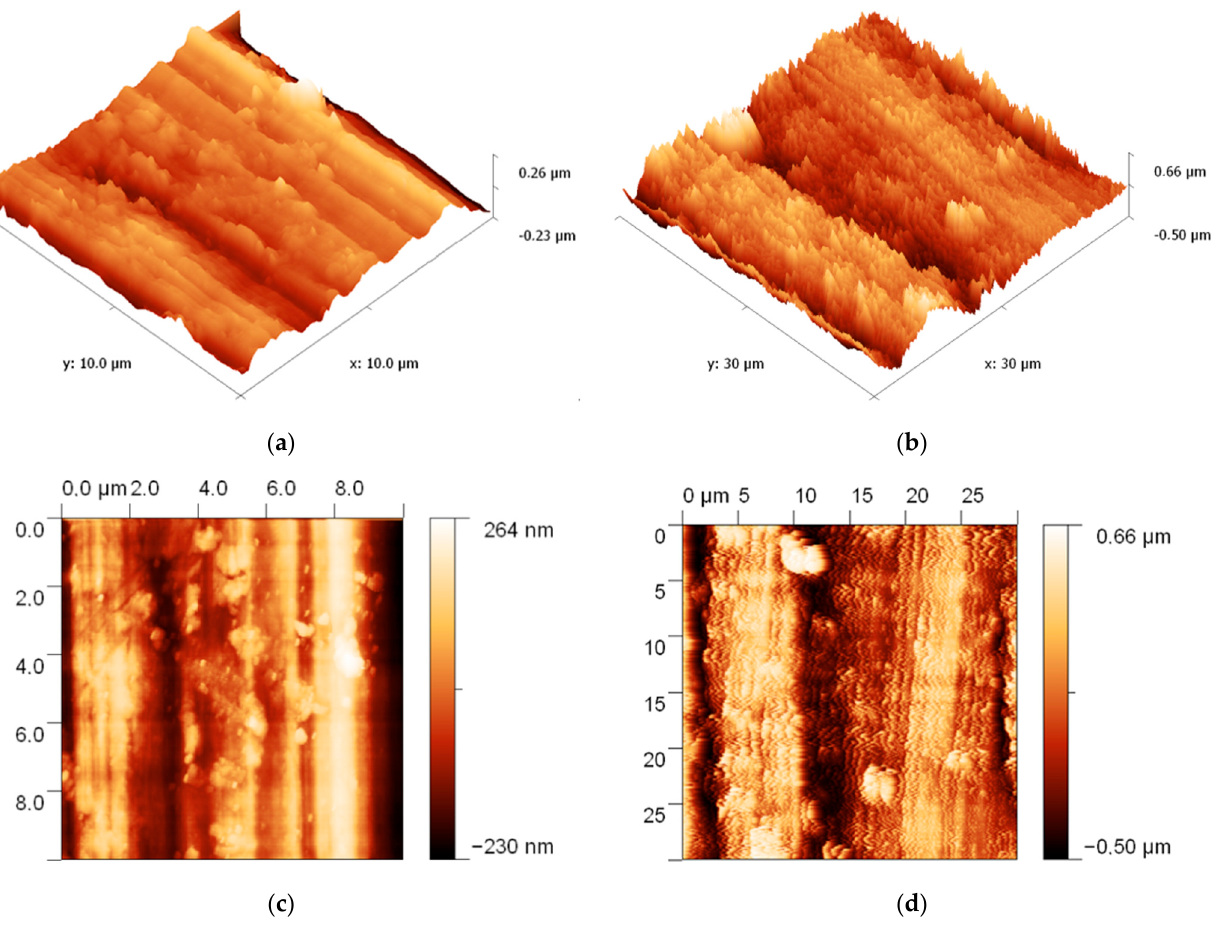
Figure 5. 3D AFM images of: ( a ) #1 sample: glucose oxidase with immobilized enzyme glucose; ( b ) #2 sample: cholesterol oxidase with immobilized enzyme cholesterol; ( c , d ) 2D AFM images of #1 sample and #2 sample.